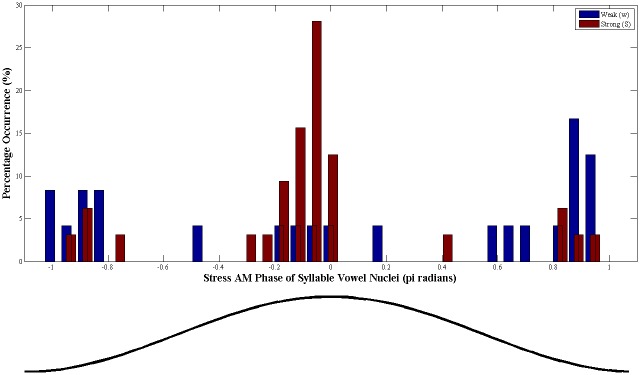
Distribution of instantaneous Stress AM phase for 'Strong' (red) and 'weak' (blue) syllable vowel nuclei.The example shown is for the trochaic-patterned nursery rhyme sentence 'Jack and Jill', and results are computed over the pooled syllable vowel nuclei from 2 speakers. The x-axis indicates the instantaneous Stress AM phase of the syllable vowel nuclei, binned into 17 equal phase bins between -π and +π radians. The curve below shows the equivalent oscillatory shape of the AM phase values on the x-axis.